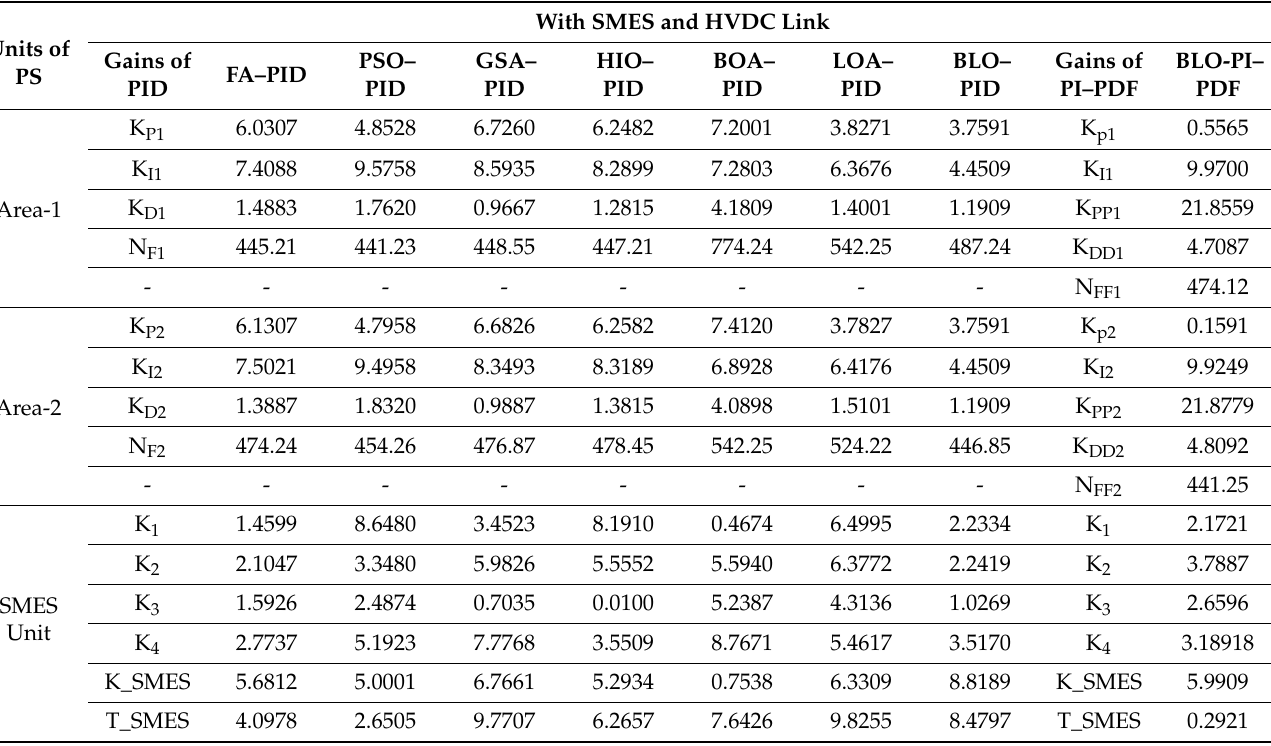
Table 2. Optimized parameters of controller for scenario-I.